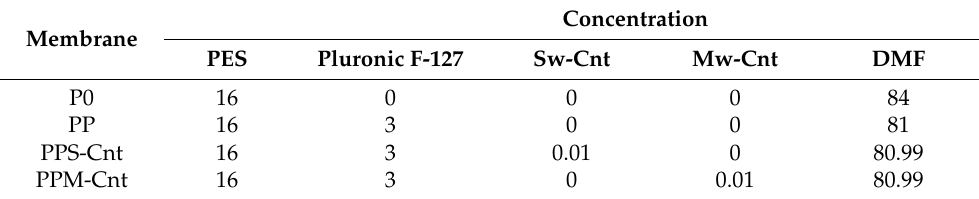
Figure 1. Illustration of membrane preparation using the phase inversion method. Table 1. Composition of dope solution for membrane fabrication.